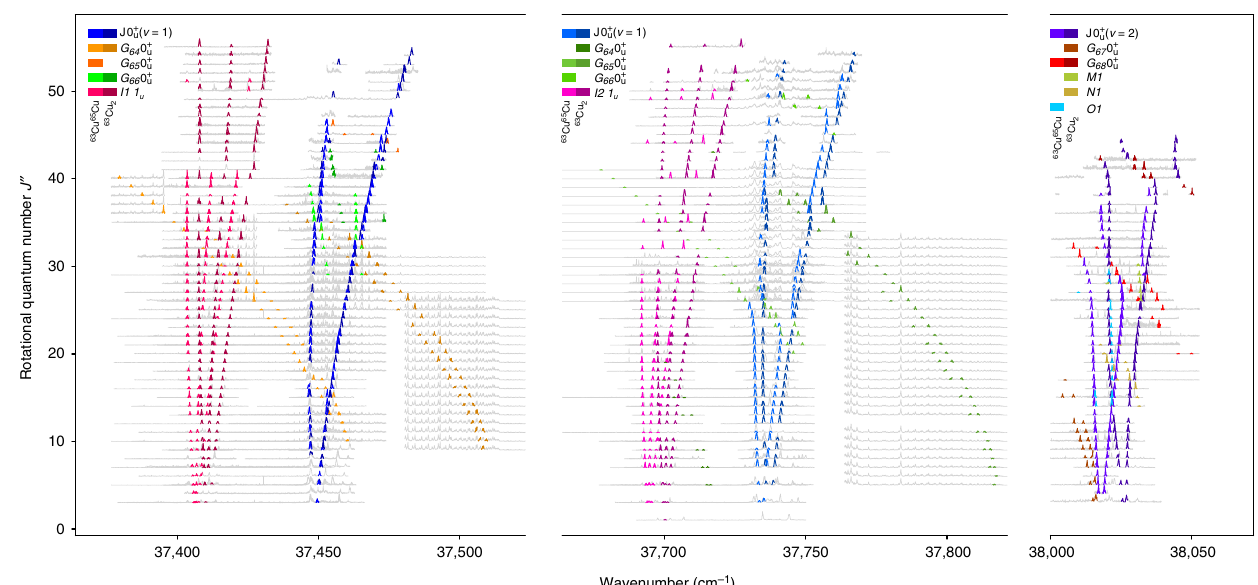
Fig. 4 Overview of all assigned lines. Total view of the transitions that were rotationally assigned in this work. The regions containing assigned lines are printed colour-coded, while the containing raw spectra are printed in grey. The colours denote the isotopologues and the vibronic states that were accessed by transitions from the vibronic ground state X 0 þ ( v = 0) with the corresponding rotational quantum number J ″ as denoted on the ordinate. Starting from g the bright transitions that were unambiguously assigned by double-resonant selection of J ″ , blocks of excitation scans into the dark regimes could be also assigned by numbering